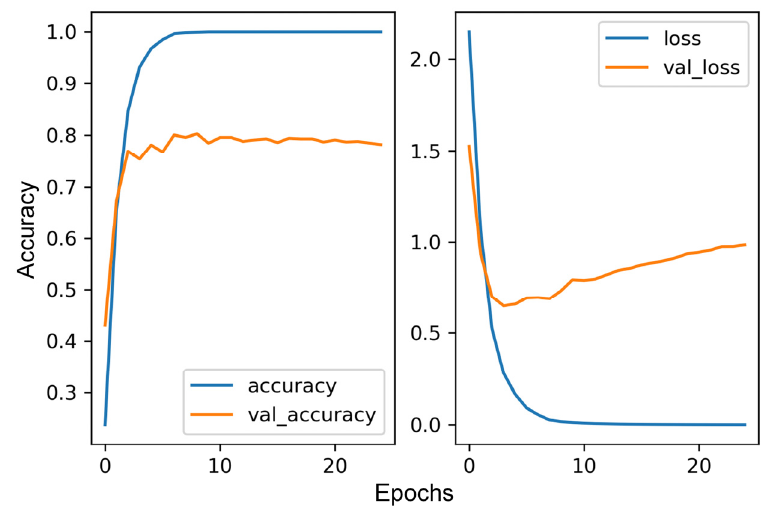
Figure 4. Learning curves of the baseline model.